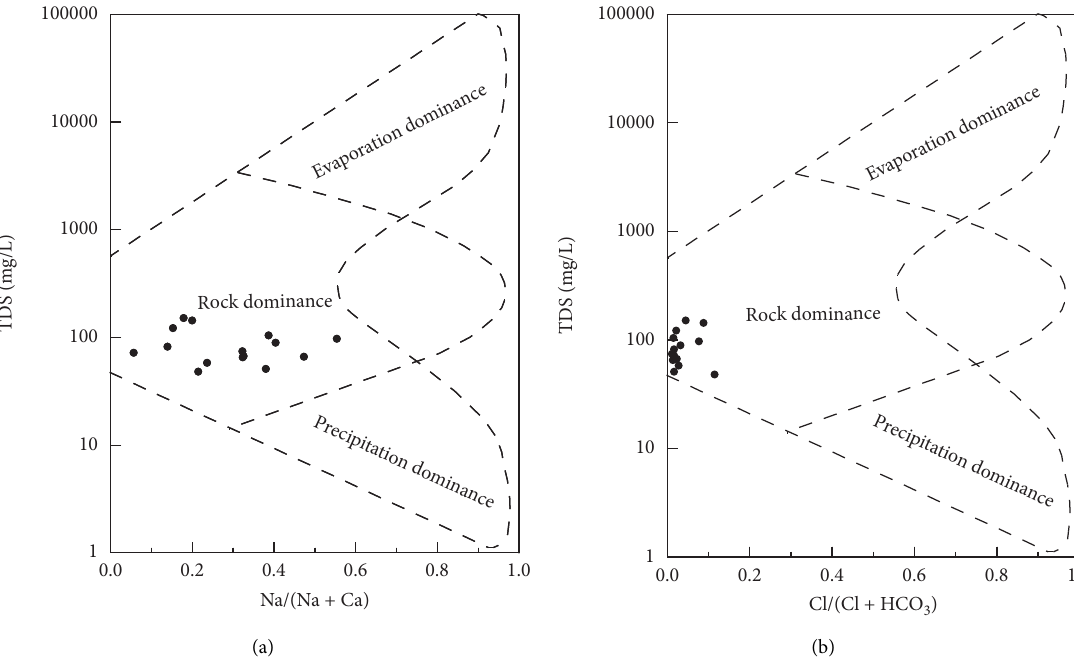
Figure 8: Gibbs diagram for groundwater